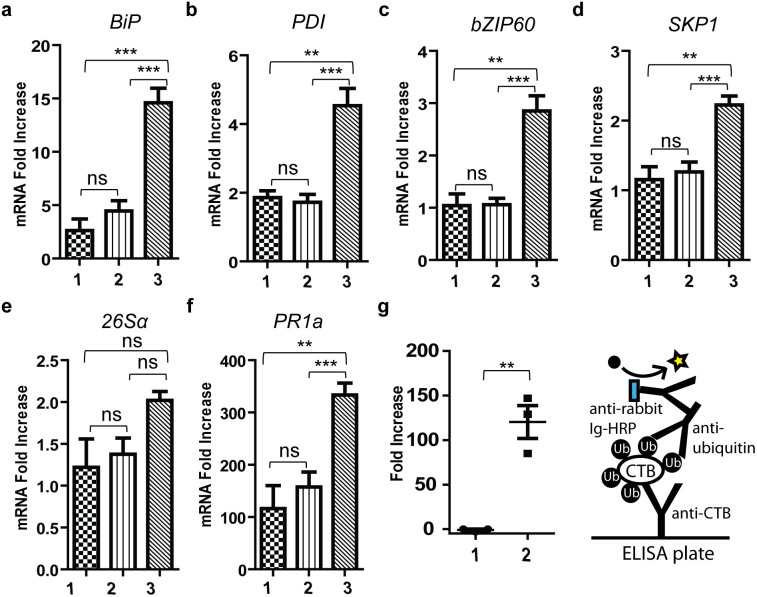
Relationship between stress response and N-glycosylation in CTB overexpression.RT-qPCR analysis of stress genes: (a) BiP (b) PDI (c) bZIP60 (d) SKP1 (e) 26Sα (f) PR1a. RNA was extracted from leaf tissues at 2 dpi. Starting amounts of cDNA for each gene were normalized to that of 18S ribosomal RNA (reference gene). Data were plotted as fold increase to the average normalized value for non-infiltrated plants and are expressed as means ± SEM of biological replicates (n = 9). **P < 0.01, ***P < 0.001, ns: not significant, one-way ANOVA with Bonferroni's multiple comparison test. Numbers 1-3 correspond to empty vector-infiltrated, gCTB-expressing and N4S-CTB-expressing plants, respectively. (g) Left: Detection of ubiquitinated CTB in leaf extracts at 3 dpi by ELISA. Data were plotted as fold increase to the average value for empty vector infiltrated plants and are expressed as means ± SEM (n = 3). **P < 0.01; unpaired two-tailed t-test. Numbers 1 and 2 correspond to gCTB- and N4S-CTB-expressing plants, respectively. Right: Schematic depicting ubiquitin ELISA.